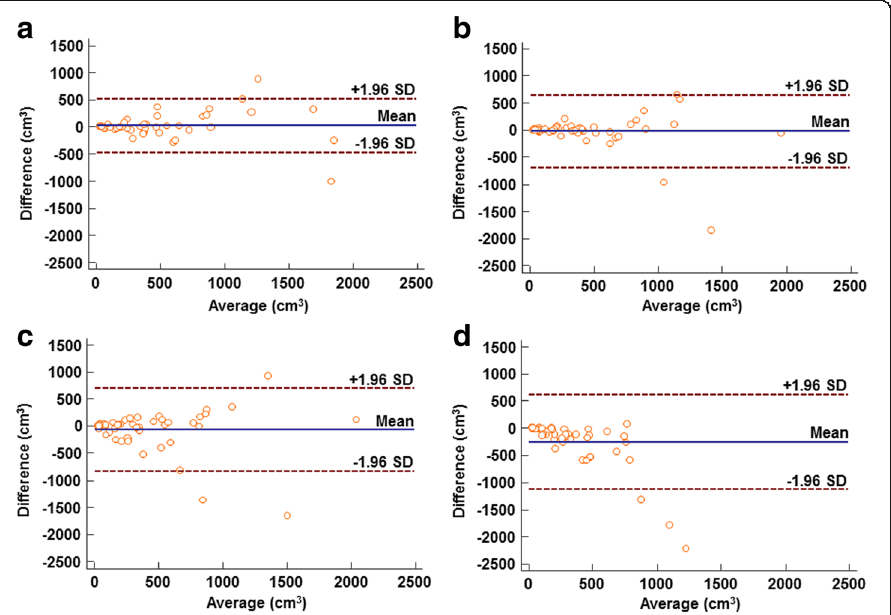
Fig. 2 Bland-Altman analyses for MTV and GTV. a MO-PET. b PET Edge ™ . c Absolute SUV threshold value of 2.0. d Percentage of SUV max value of 30%. The Bland-Altman bias results show 26.0 ± 489.6, − 26.46 ± 668.82, − 69.3 ± 765.8, and − 255.0 ± 876.6 cm 3 for MO-PET, PET Edge ™ , SUV 2.0 and 30% SUV max ,